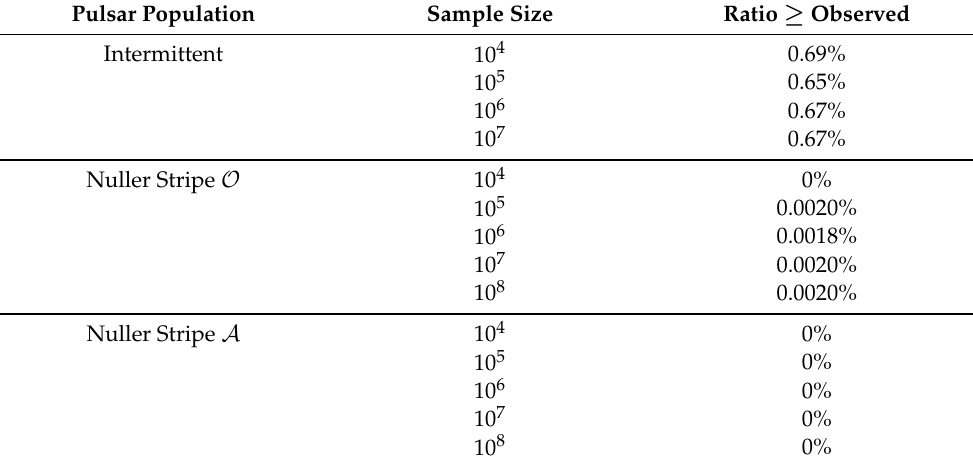
Table 2. The ratio of Monte Carlo simulated samples (with the same number of pulsars in each sample as in the observed population tagged by the first column) with an average silhouette value equal or above that of the actual observed population. Note that sample size refers to the number of Monte Carlo simulations, not the number of pulsars in the mock up